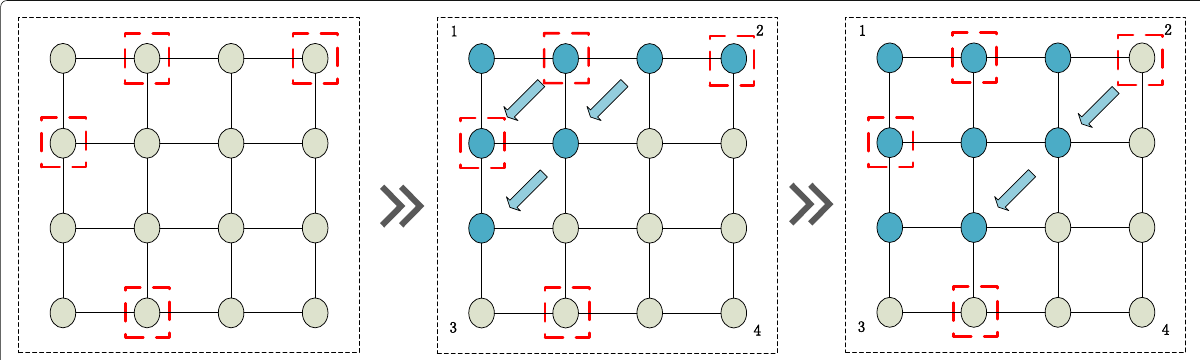
Fig. 9 The process of the proposed dynamic grouping method. Each node represents a geographic area. Nodes with red maker are jam areas. Two geographic area groups are distinguished with different colors finally